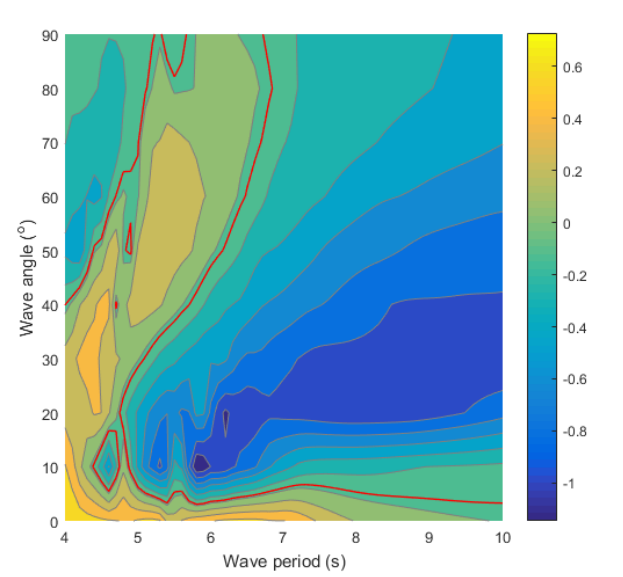
Fig. 8. Power extraction through duck pitch motions, measured in Watts.